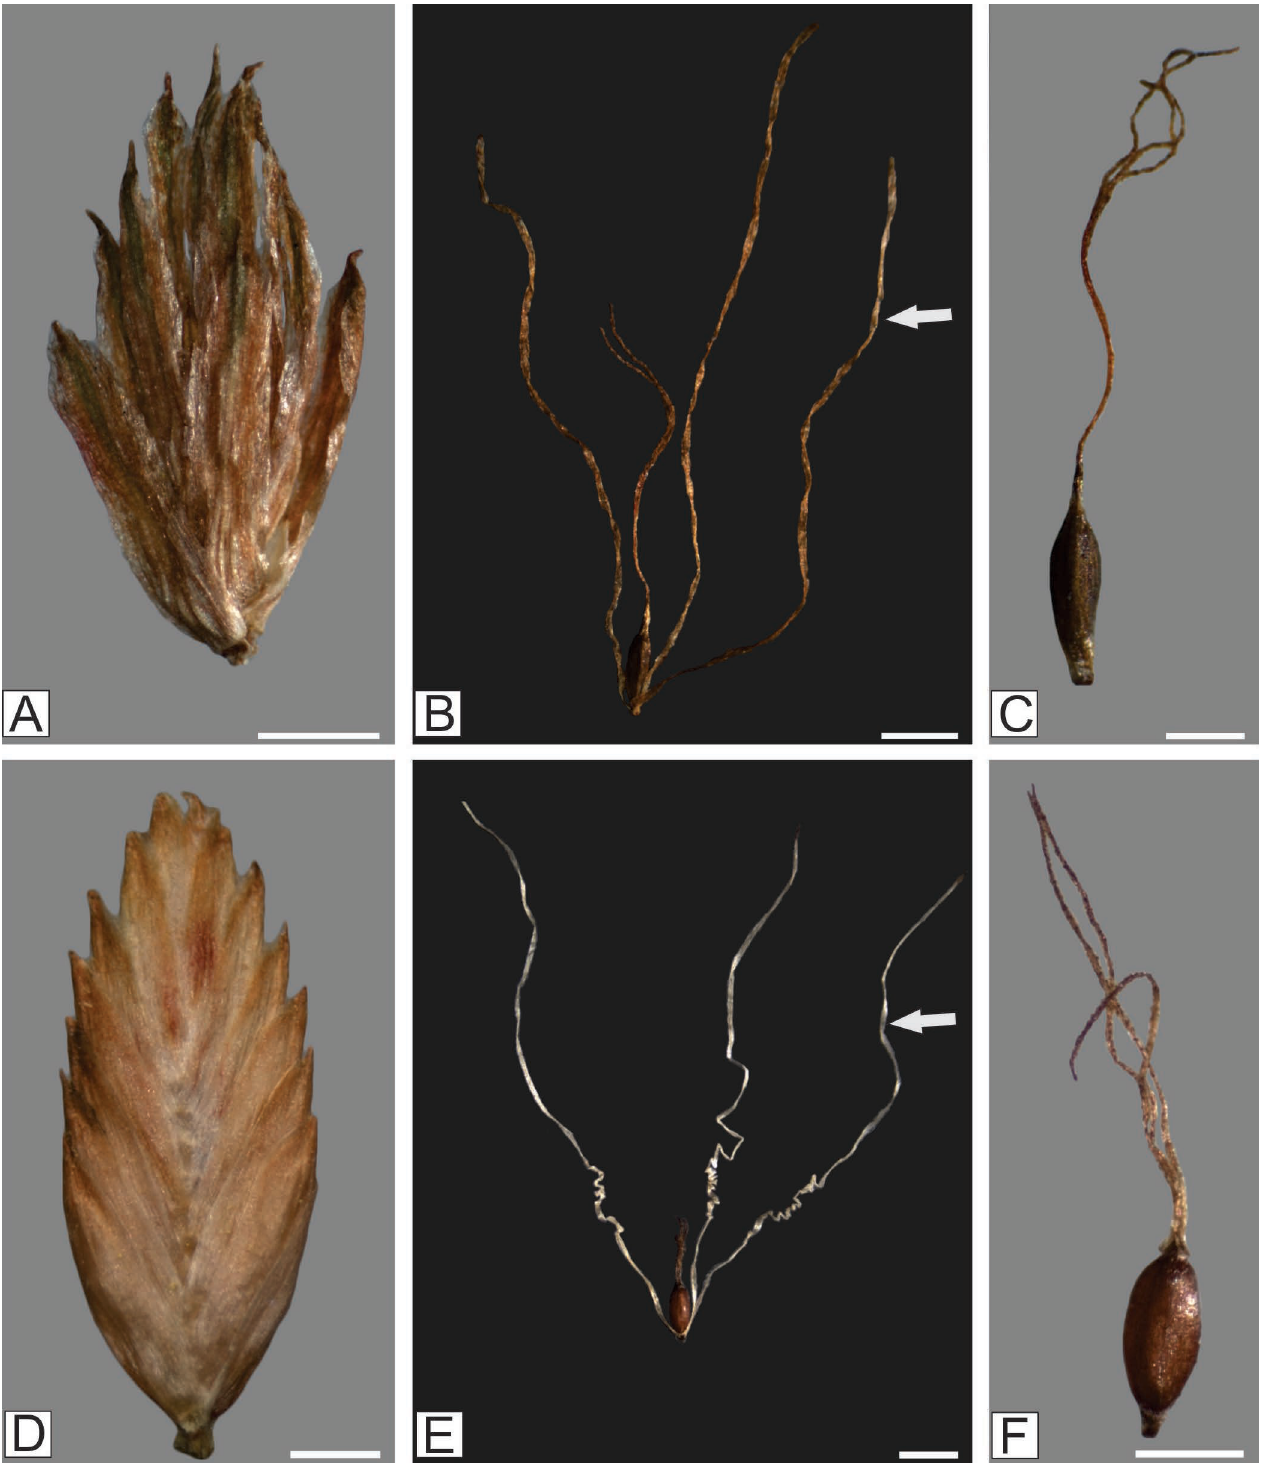
Figure 2 – A – C . Cyperus byssaceus. A . Spikelet. B . Elongated stamen filaments (arrow) adhered to the fruit. C . Mature fruit. D – F . Cyperus trigynus. D . Spikelet. E . Elongated stamen filaments (arrow) adhered to the fruit. F . Mature fruit. A from R. Trevisan 1673 (FLOR). B, C from S.M. Hefler & G.H. Silveira 702 (ICN). D from F. Gonzatti 276 (FLOR). E, F from R. Martins 111 (FLOR). Scale bars: A, B, D, E = 1 mm; C, F = 0.5